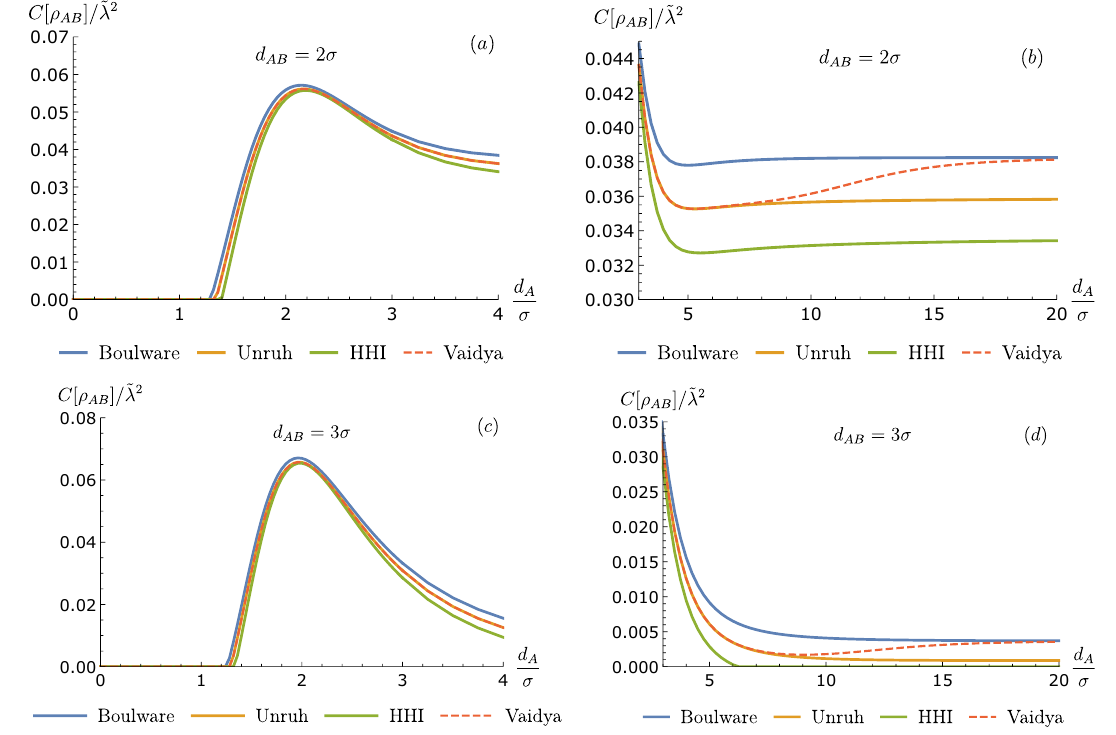
Figure 3 . The concurrence as a function of proper distance of Alice’s detector away from the horizon (in units of (cid:27) ) for various choice of vacua. Here ~ (cid:21) = (cid:21)(cid:27) 1 (cid:0) n 2 = (cid:21) is dimensionless coupling constant. We set (cid:10) (cid:27) = 2, M=(cid:27) = 1 . The detectors are turned on at (cid:28) 0 = 12 (cid:27) so that the Gaussian 2 switching peak is very far from the shell. (a) d ( r A ; r B ) = 2 (cid:27) , near the horizon. (b) d ( r A ; r B ) = 2 (cid:27) , far from the horizon. (c) d ( r A ; r B ) = 3 (cid:27) , near the horizon. (d) d ( r A ; r B ) = 3 (cid:27) , far from the horizon.